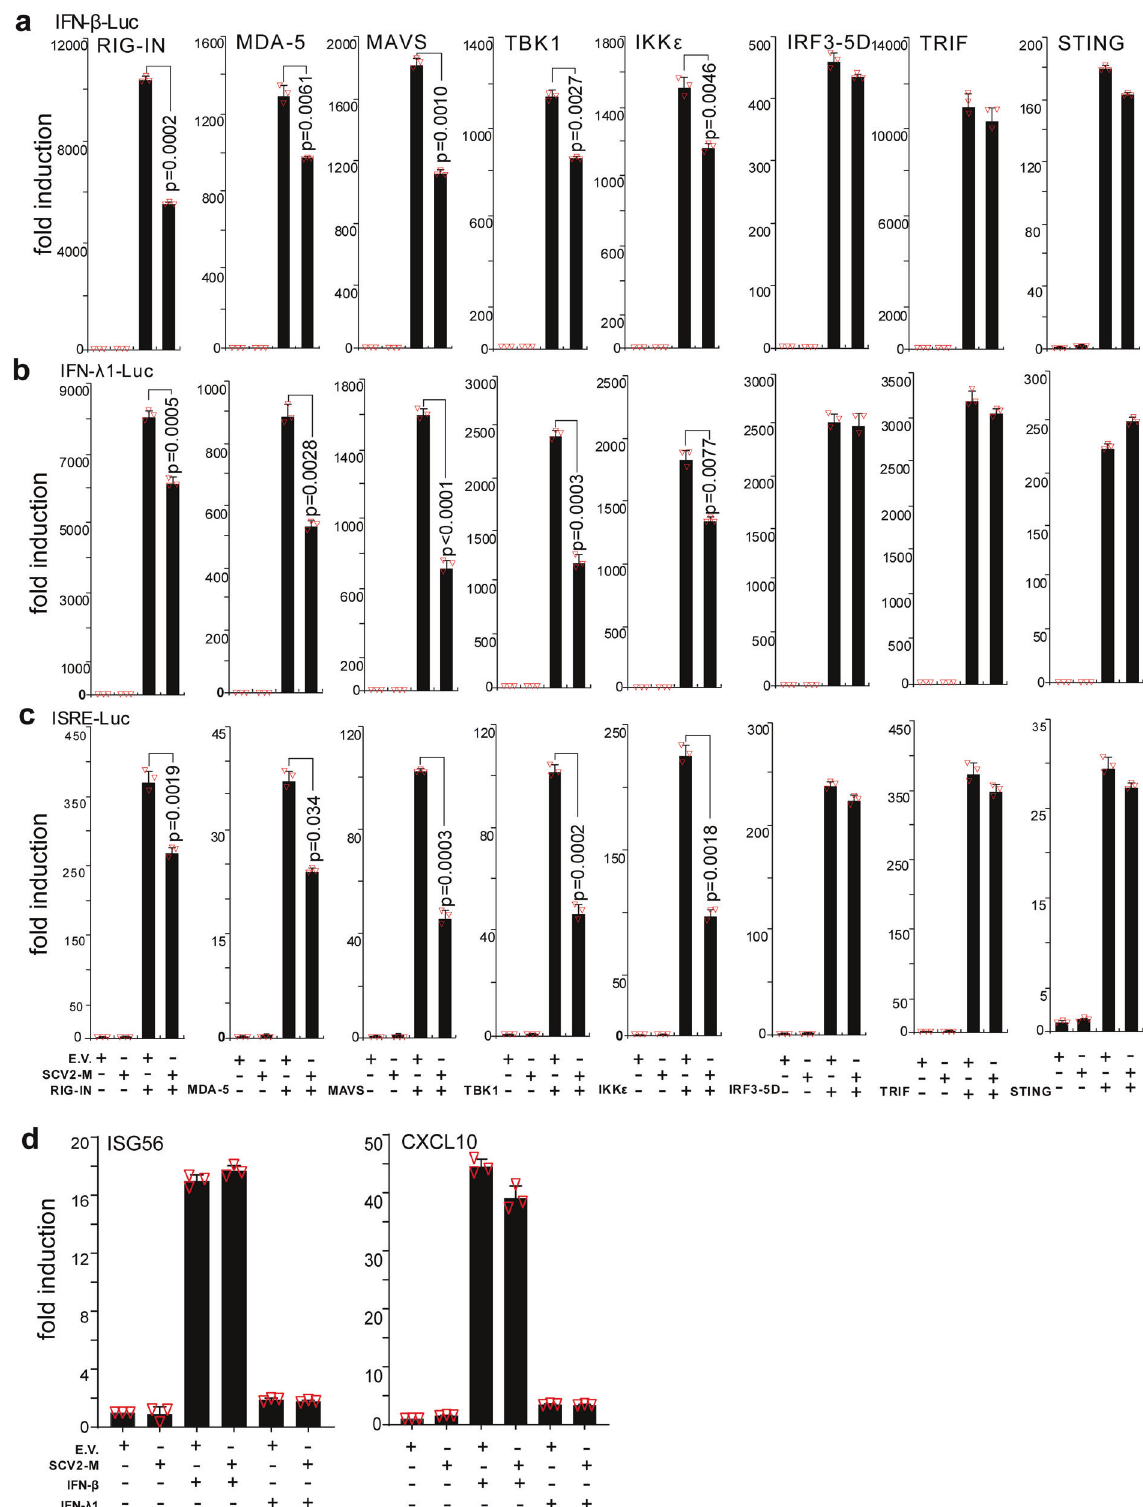
The SARS-CoV-2 M protein interacts with RIG-I, MDA-5, MAVS, and TBK1 To identify the mechanism by which the SARS-CoV-2 M protein affects IFN signaling activation, coimmunoprecipitation